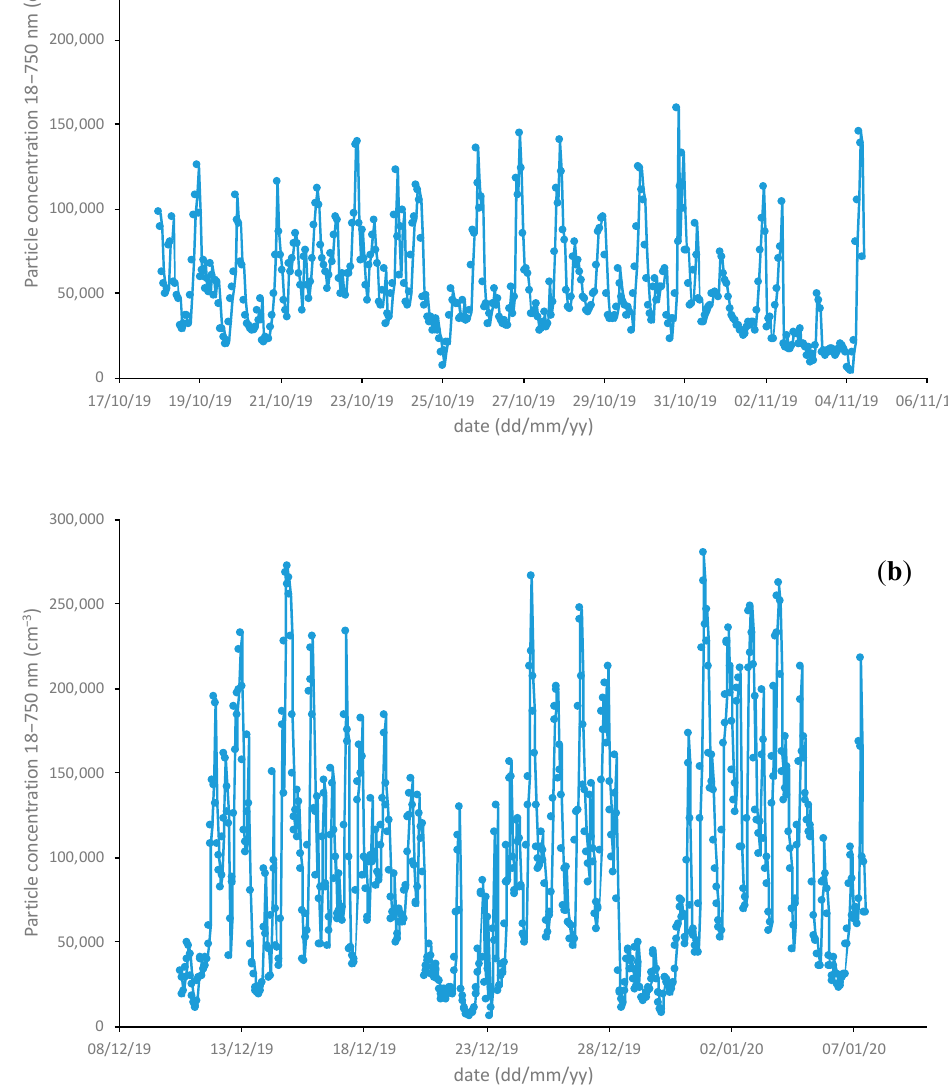
Figure 2. Particle number concentration (PNC) (cm − 3 ) in the range 18–750 nm in ( a ) October and in December ( b ). Each point represents an hourly value.